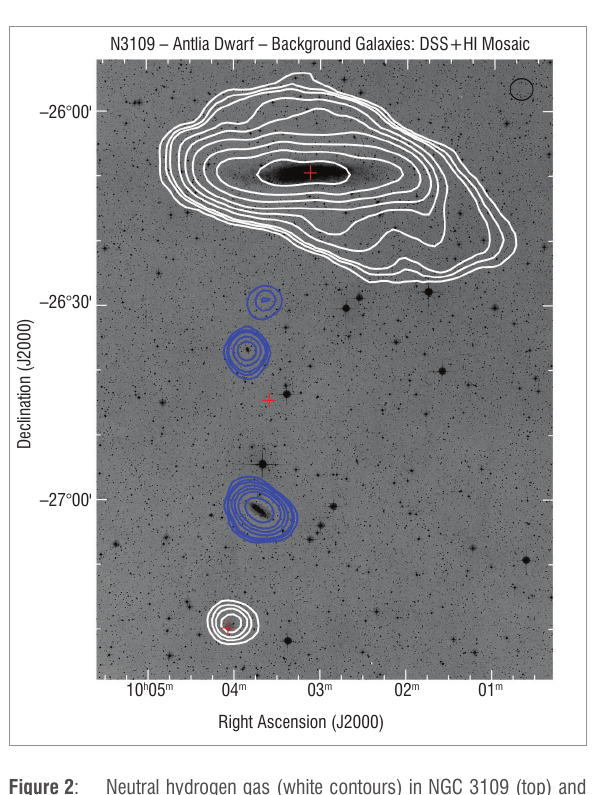
Figure 2 : Neutral hydrogen gas (white contours) in NGC 3109 (top) and the Antlia dwarf galaxy (bottom) as observed with KAT-7. 3 The observations are overlaid on an optical image of this part of the sky. The blue contours correspond to background galaxies.